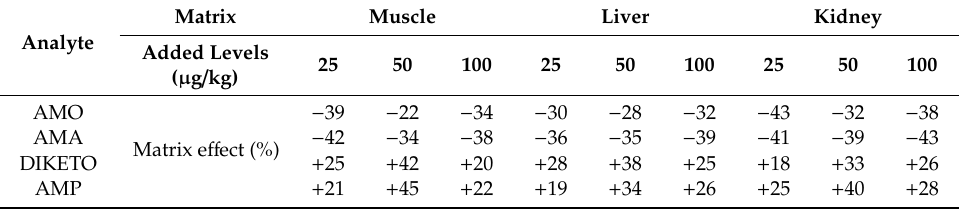
Table 4. Matrix e ff ects of the three matrices on AMO, AMA, DIKETO, and AMP at di ff erent